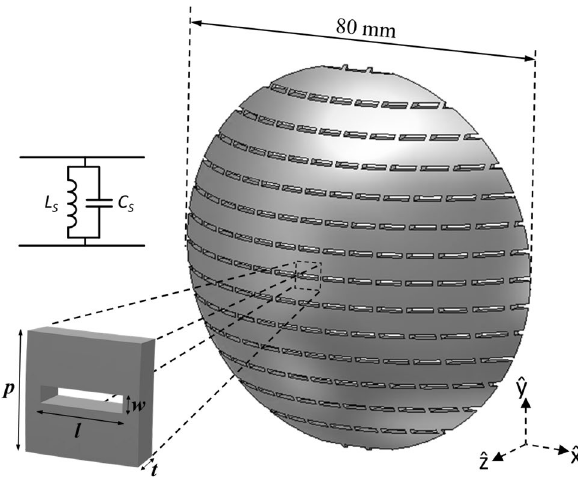
Figure. 1. 3D view of the conformal FSS, the conformally bent unit cell that are normal to the z-direction, and the equivalent circuit of the unit